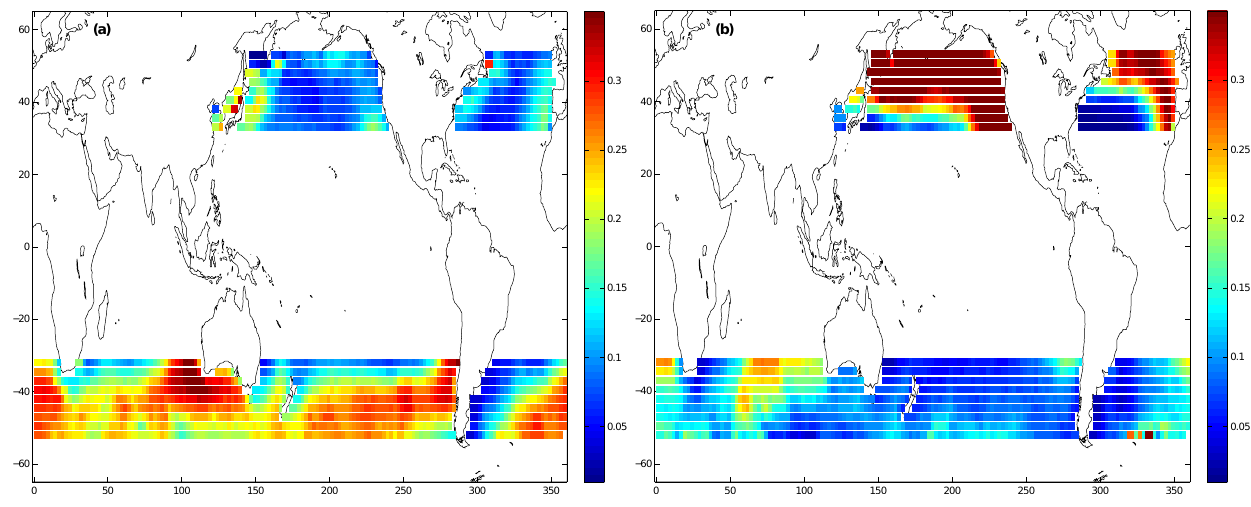
Fig. 10. As in Fig. 9, except for Cluster 3 (Stratocumulus/Stratus), (a) DJF and (b) JJA.